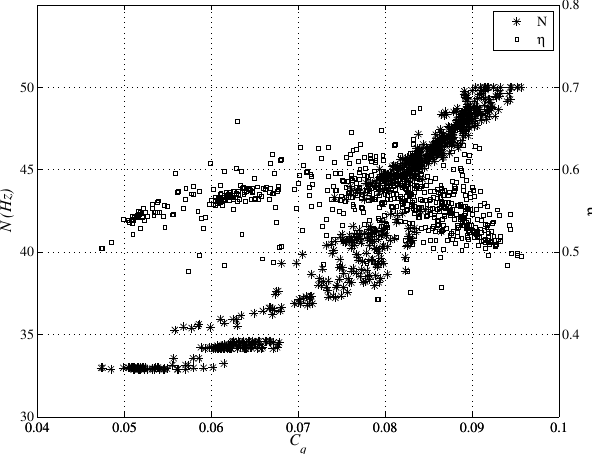
Figure 10. Pump speed, N , and efficiency, η , values against dimen- sionless flow, C q